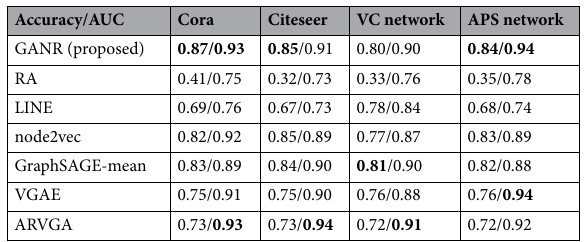
Table 1. The comparison of different algorithms over link prediction task under Accuracy and AUC metric. Bolded numbers are best results among the comparisons in the same column.